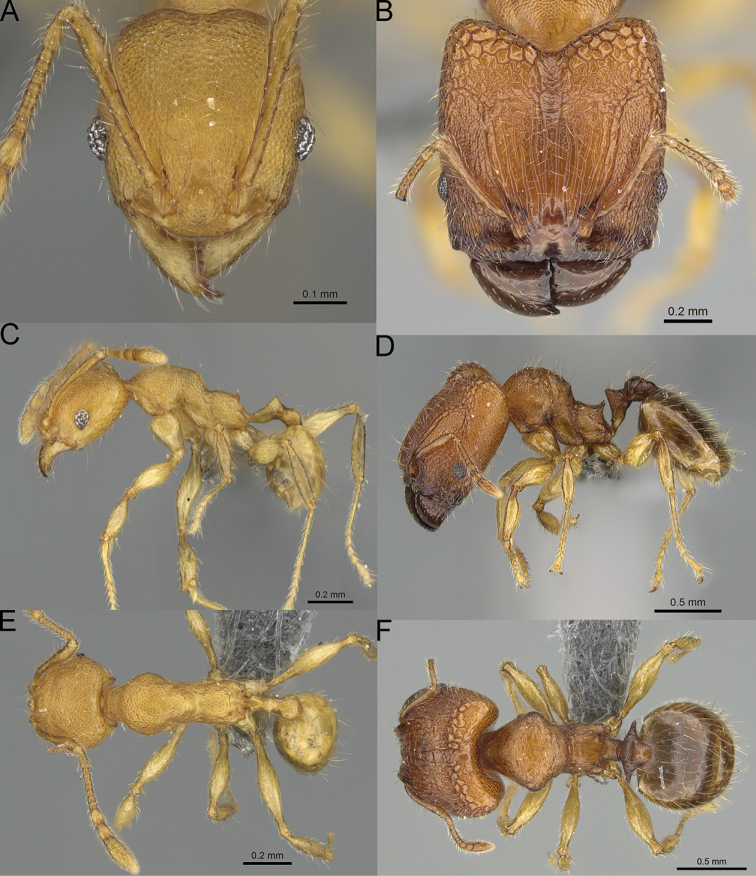
Pheidole
masoala sp. nov., full-face view (A), profile (C), and dorsal view (E) of paratype minor worker (CASENT0923165) and full-face view (B), profile (D), and dorsal view (F) of holotype major worker (CASENT0375363).